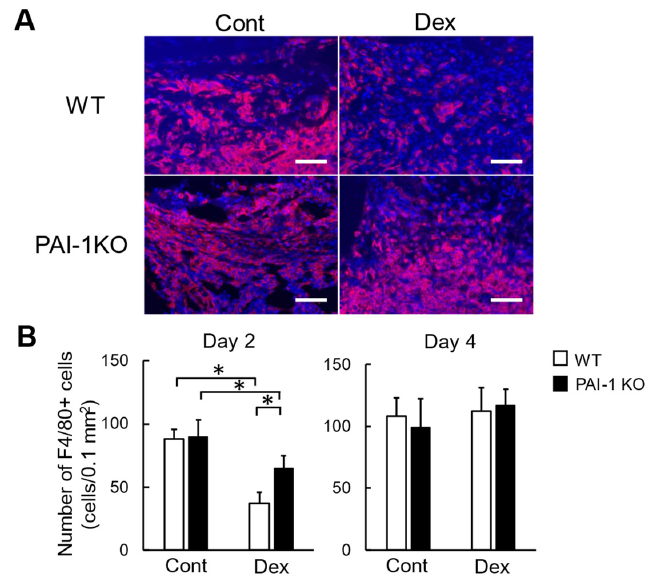
Figure 1. Effects of PAI-1 deficiency on Dex-induced decreases in macrophage number after femoral bone injury. ( A ) Microphotographs of F4/80-positive cells at damaged sites 2 days after femoral bone injury in control and Dex-treated WT and PAI-1 KO mice. Scale bars indicate 50 µ m. ( B ) Number of F4/80-positive cells at damaged sites 2 and 4 days after femoral bone injury in control and Dex-treated WT and PAI-1 KO mice. Data represent the mean ± SEM: n = 5 mice in each group. * p < 0.05. Cont, control; DAPI, 4 (cid:48) ,6-diamidino-2-phenylindole.